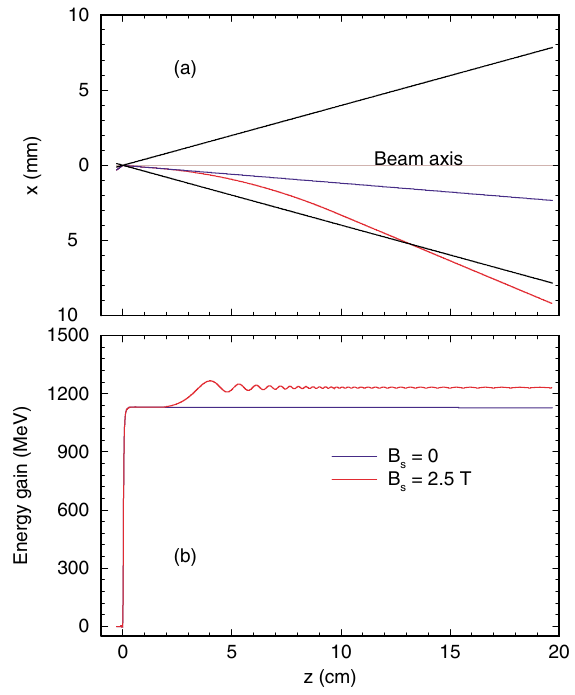
FIG. 12. (Color) Ejection of a captured electron from the laser beam. (a) The trajectories, and (b) the energy gain, of an (cid:3) 8 : 11 and (cid:6) (cid:3) 6 (cid:1) towards a point electron injected with (cid:15) i 0 (cid:3) = 5 to the right of the beam focus from a point with z z r 0 (cid:2) 3 mm . The beam parameters are output power P (cid:3) 10 PW (cid:3) 8 (cid:28) m , (cid:20) (cid:3) 1 (cid:28) m , and (cid:3) 0 . In this example, ( q (cid:17) 86 ), w 0 0 (cid:3) 2 : 5 T and pointing in a uniform magnetic field of strength B s the (cid:2) y direction (see Fig. 1) is used to eject the electron out of the beam. The total time of interaction is such that !t (cid:3) 4 (cid:21) (cid:9) is on only in the region 1 : 7 < z < 9 : 7 cm covered 10 5 and B s < (cid:24) t < 0 : 5 T , where T is the total during the interval 0 : 1 T i i i interaction time. In (a) the dark black lines mark the beam boundaries as defined in Sec. IV. The legends in (b) apply to (a) as